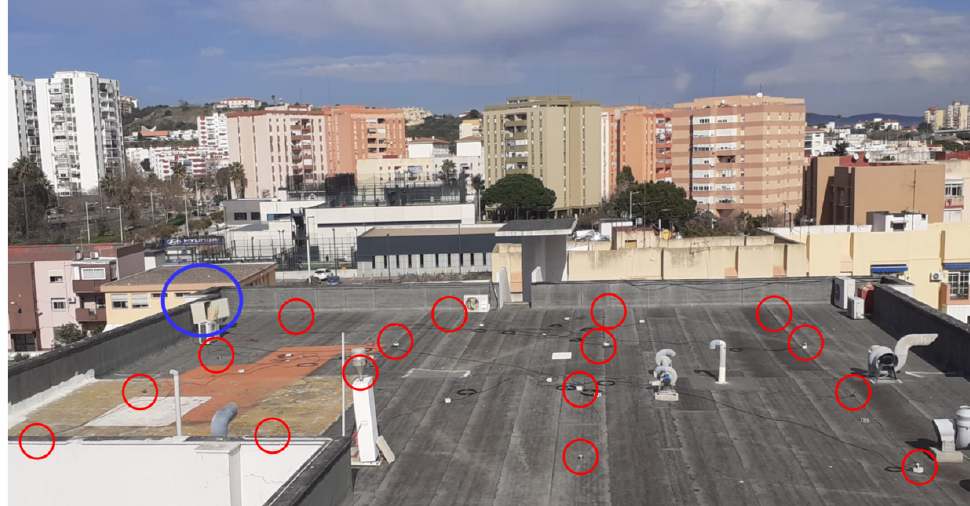
Figure 11. WSN deployed at the rooftop of the University building. Red circles indicate pyranometers, and the blue circle locates the position of the router and AC–DC power